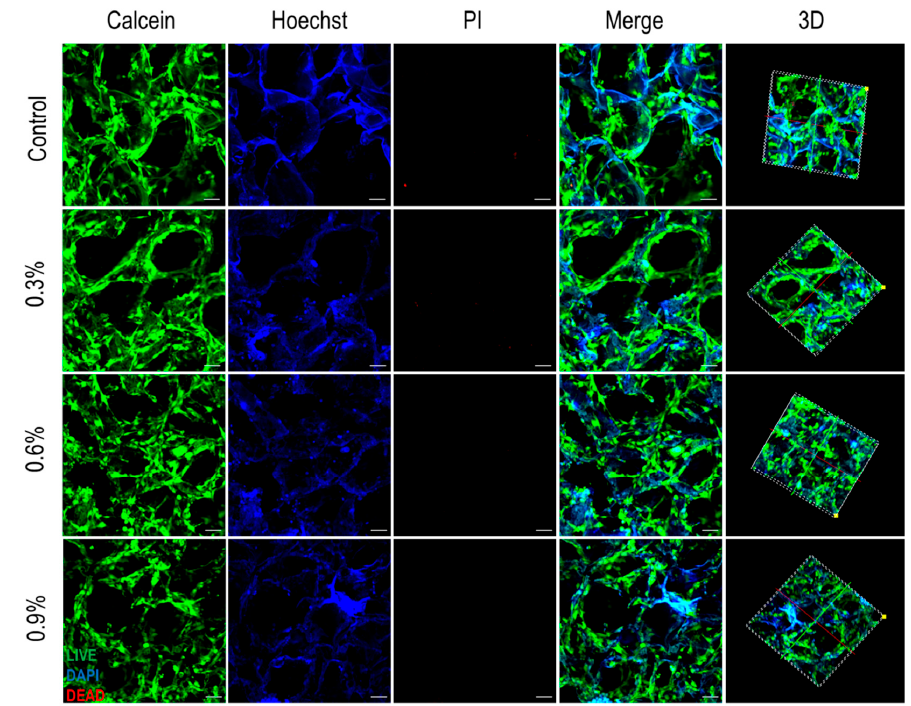
Figure 8. The viability and distribution of MC3T3-E1 cells on CS/Gel/nHAp/MWCNTs scaffolds. Calcein (green) staining showing the spread of live cells, Hoechst (blue) staining showing the cell nucleus, and PI (red) staining showing the spread of the dead cells. The 3D synthesis diagram showing the spread of cells in the 3D structure of the scaffolds. (Incubation for 2 days, scale: 50 μ m).